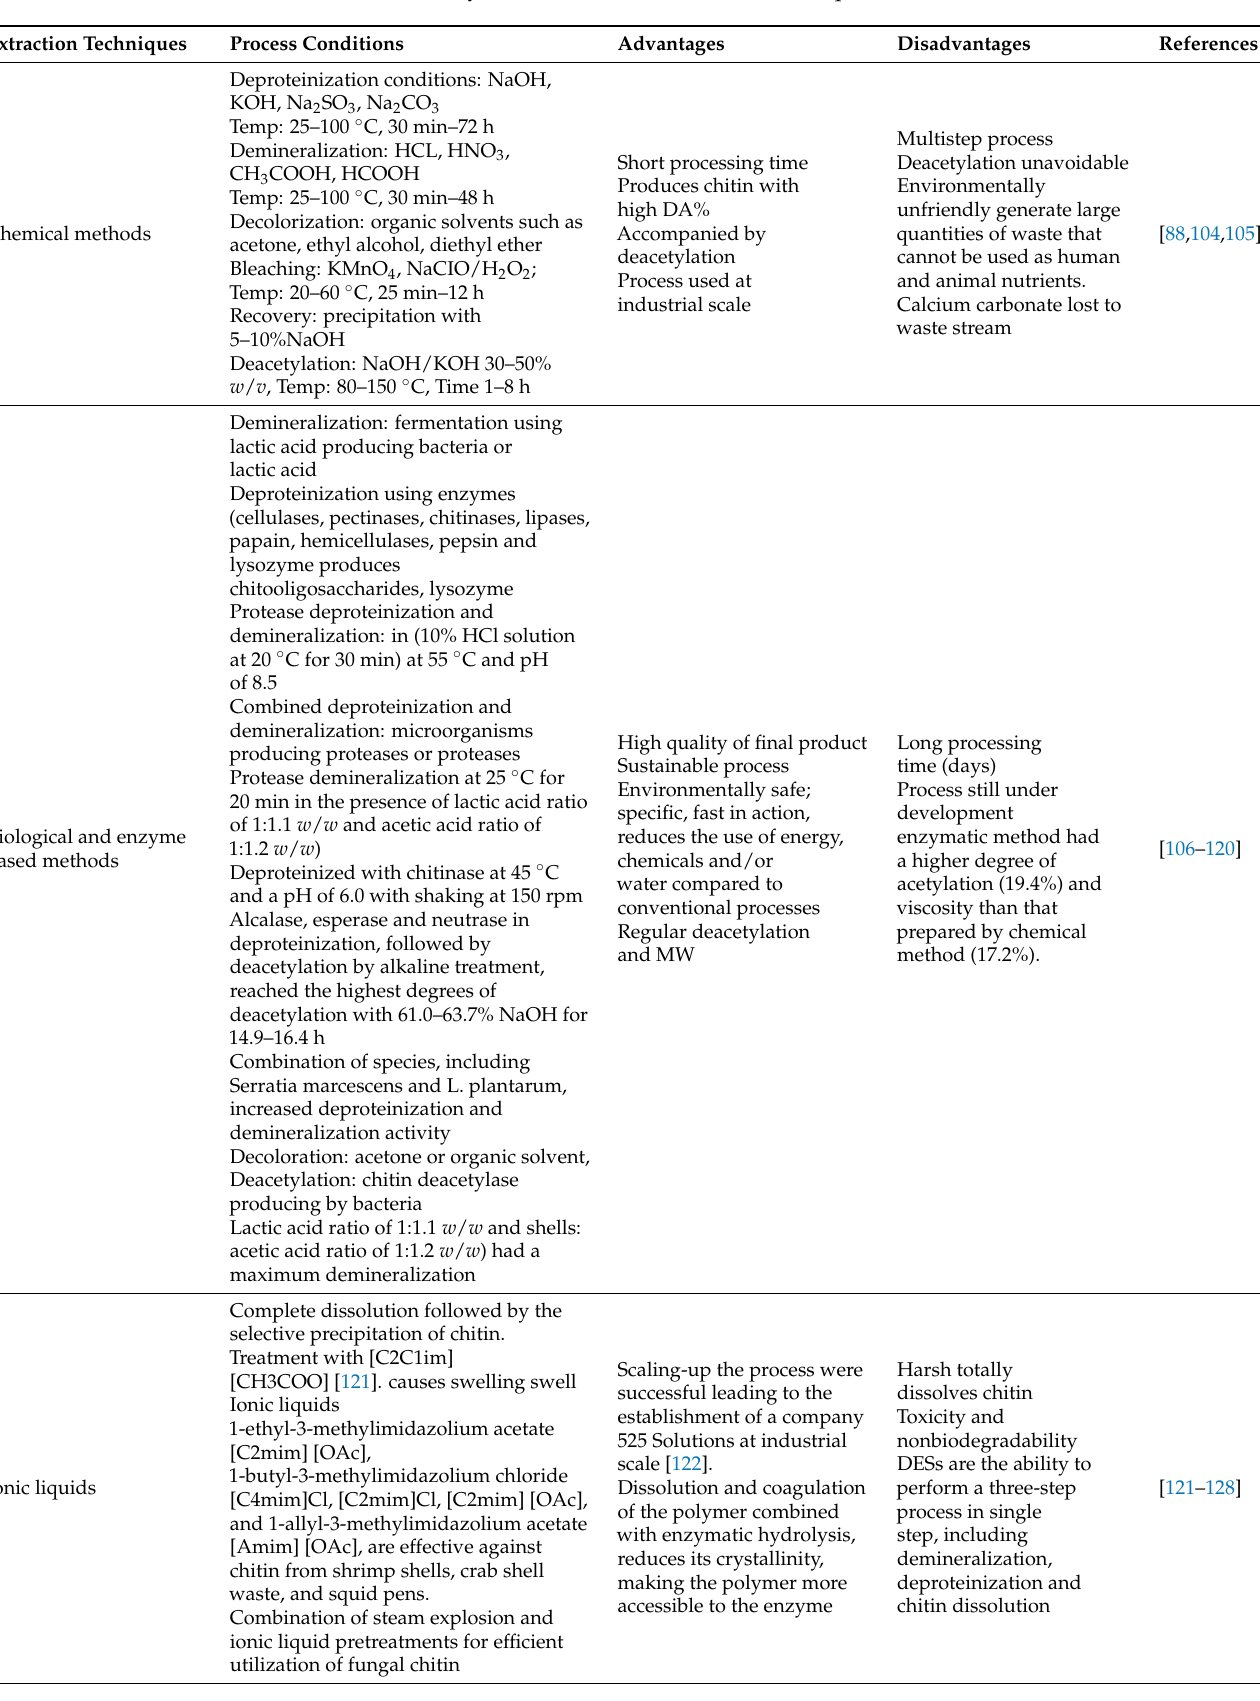
Table 2. Summary of different chitin extraction